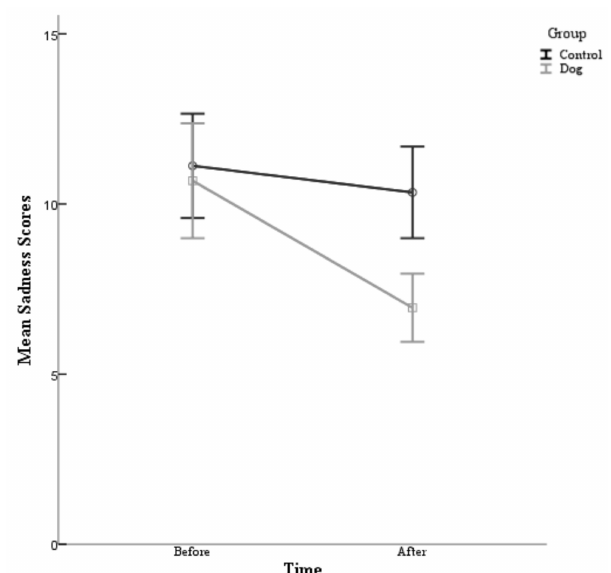
Figure 3. The mean sadness scores are plotted for the participants in the control condition and the participants in the experimental (dog) condition before their interaction and after their interaction with 95%-confidence-interval error bars.